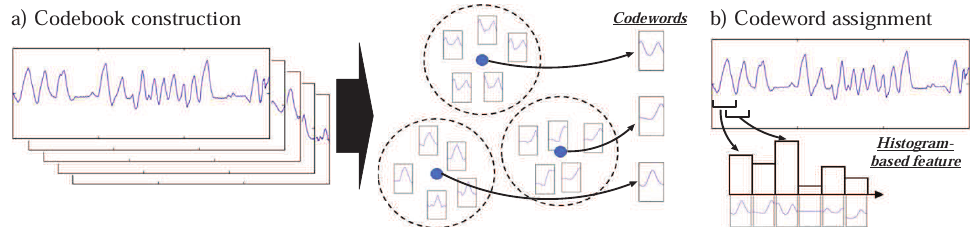
Figure 2. An overview of the codebook